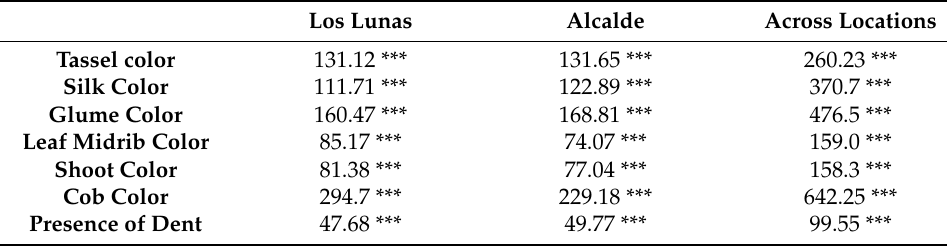
Table 3. Chi-square analysis of different qualitative traits evaluated across different environments of New Mexico. Los Lunas Alcalde Across Locations Tassel color 131.12 *** Silk